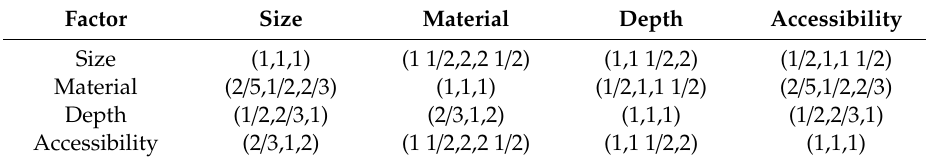
Table 3. Economic sub-factors pairwise comparison (lower, most probable,